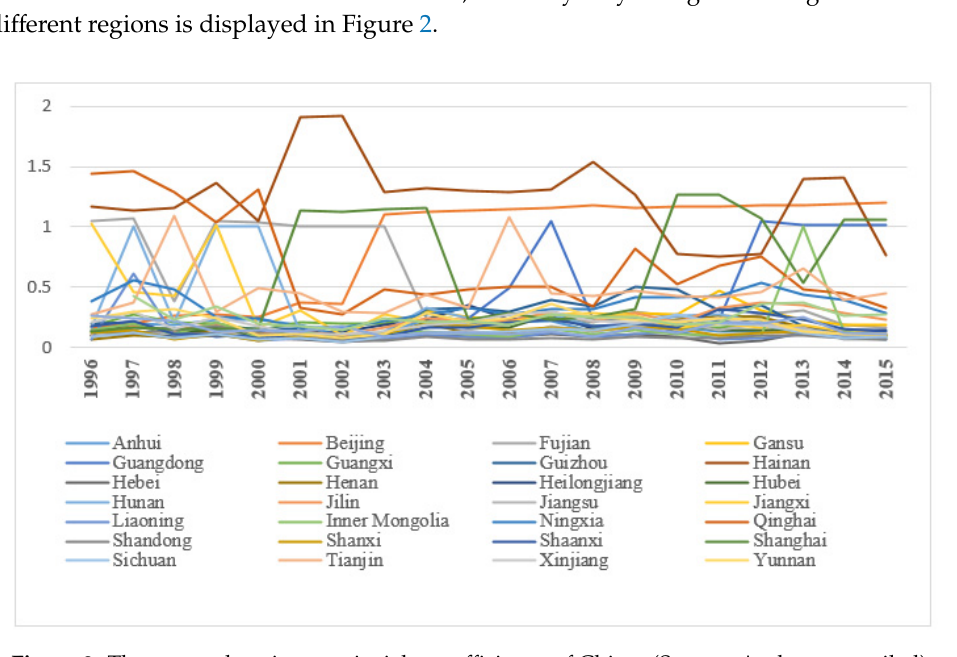
ffi ciency of China. (Source: Authors Figure 2. The comprehensive provincial eco-efficiency of China. (Source: Authors compiled). Figure 2. The comprehensive provincial eco-e